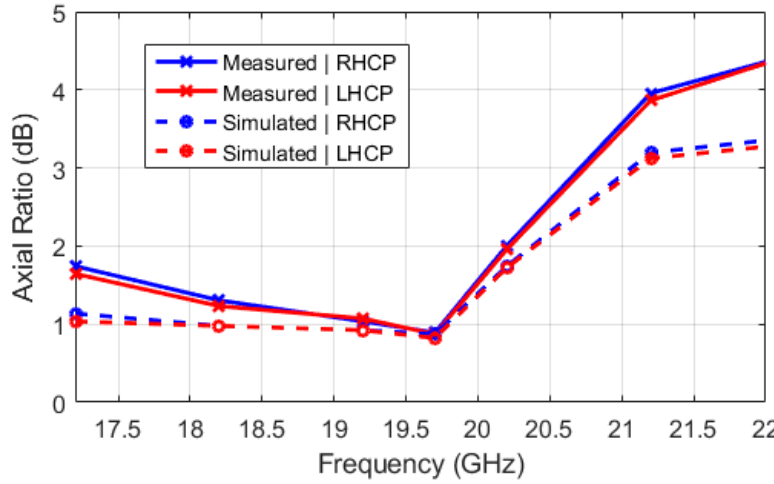
Figure 11. Measured and simulated axial ratio as a function of frequency.